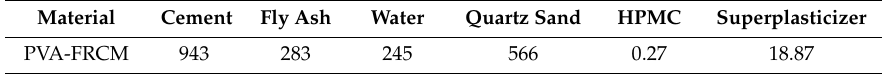
Table 4. Mixture proportions of cement-based material reinforced by polyvinyl alcohol fiber (PVA-FRCM) (kg / m 3